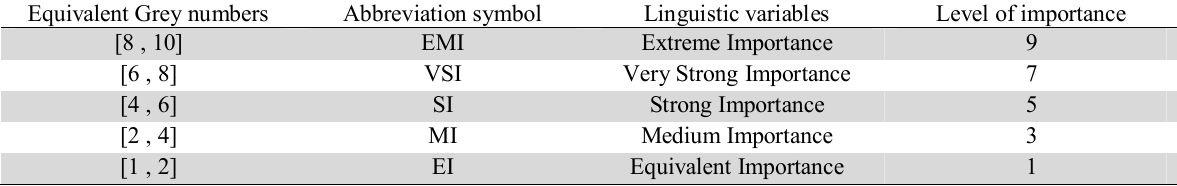
Linguistic variables of the paired comparisons matrix in AHP questionnaire